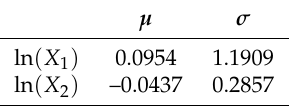
Table 2. Parameter estimates for the log